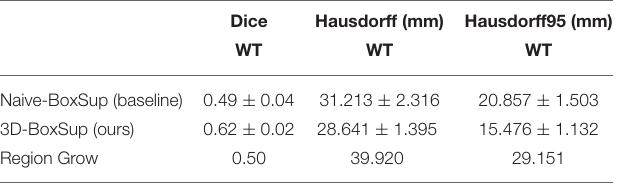
TABLE 1 | Mean values of Dice and Hausdorff measurements of the proposed method on the BraTS 2018 validation